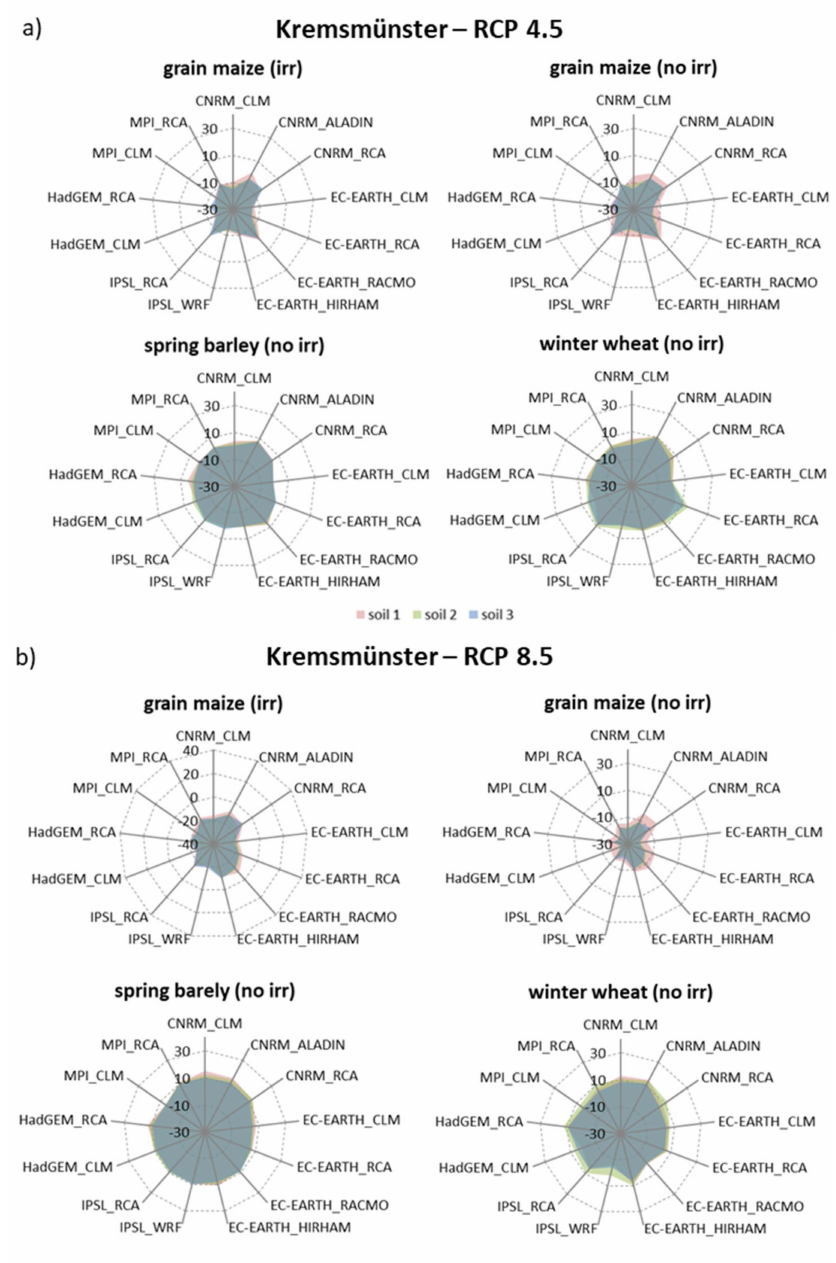
Figure 8. ÖKS15 projection-based simulated yield differences (2071–2100 vs. 1981–2010) for grain maize (optimal irrigated = irr; rainfed = no irr), spring barley (no irr), and winter wheat (no irr) growth in three different soil classes (soil 1 = pink, soil 2 = green, soil 3 = blue) (RCP 4.5 ( a ) and RCP 8.5 ( b )) at